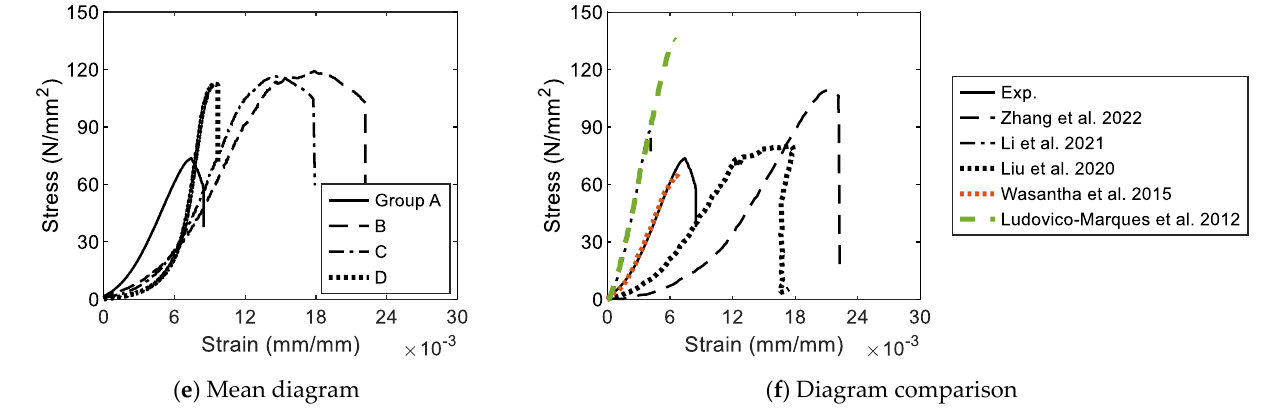
Figure 5. Stress – strain diagrams.